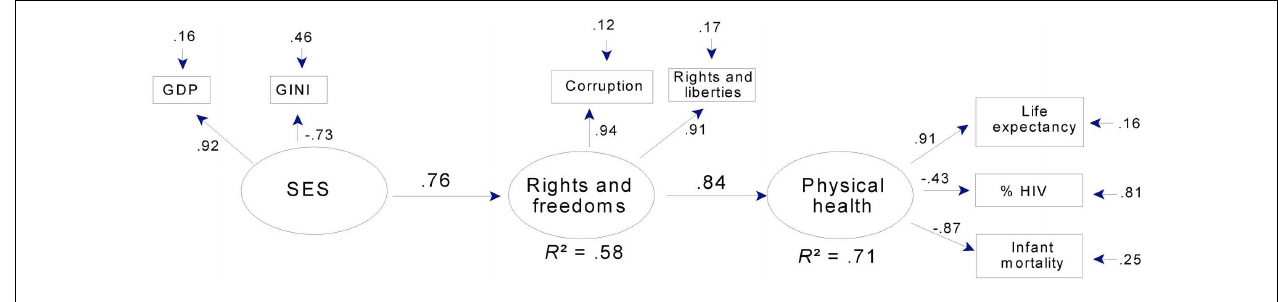
ratings for political rights and civil liberties (see text). Gini: high scores = economic inequality. GDP = Gross domestic product per capita.